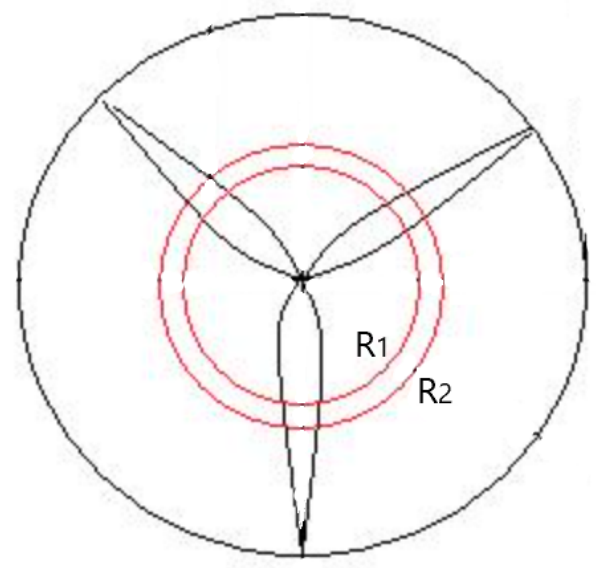
Figure 6. Blade element bounded by radii R 1 and R 2